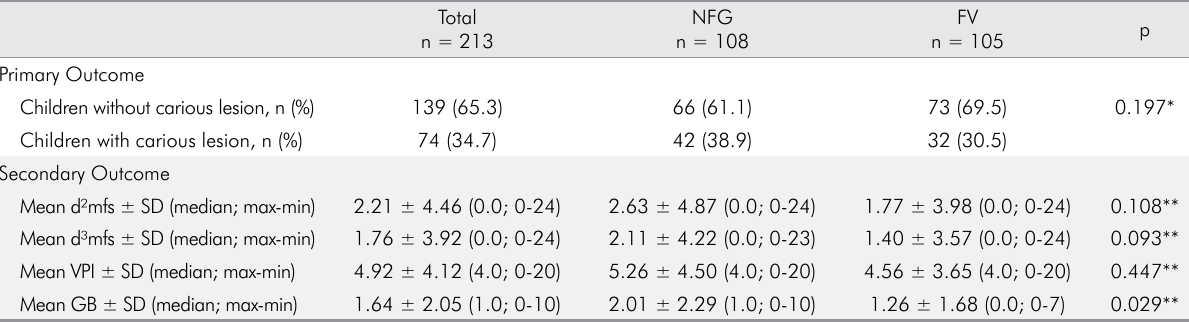
Table 2. Baseline comparison of NFG and FV groups.